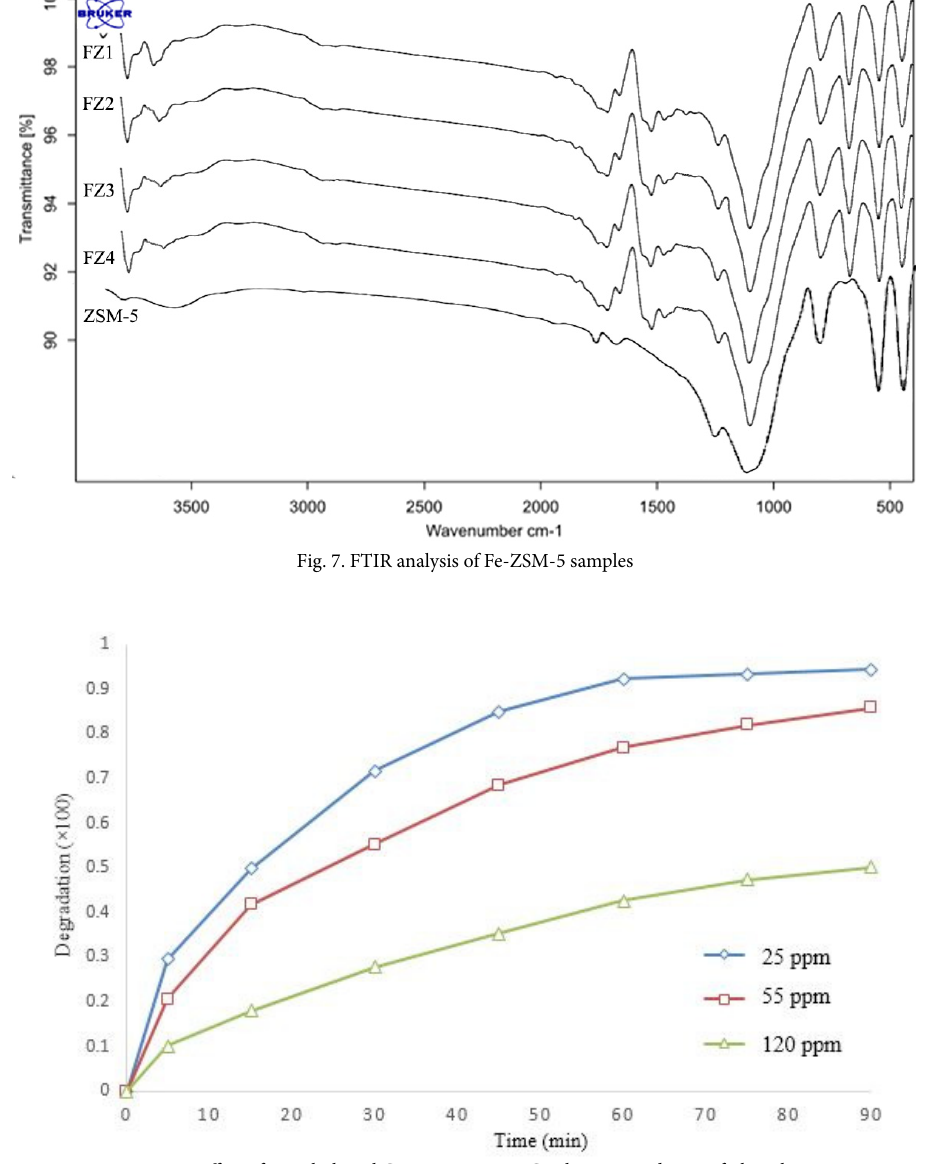
Fig. 8. Effect of Initial Phenol Concentration on Catalytic Degradation of